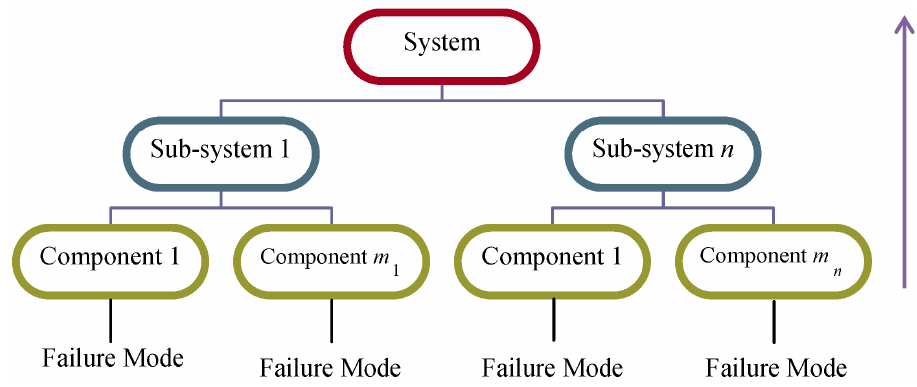
Figure 1. Hierarchical structure of a